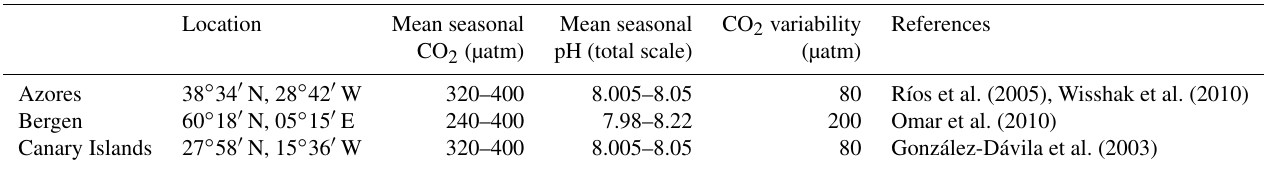
Table 1. Surface seawater CO 2 levels and pH at the Azores, Bergen, and Canary Islands. Location Mean